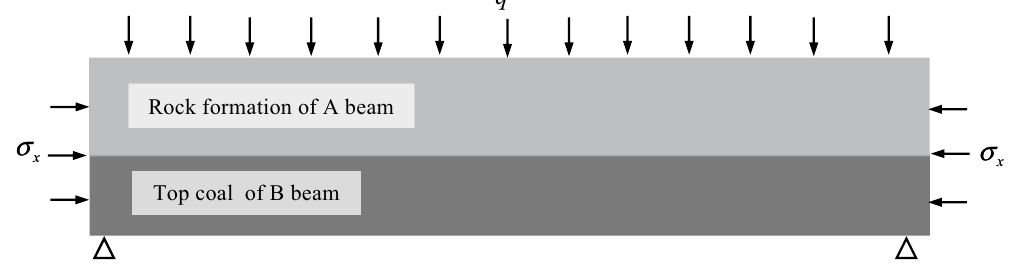
Figure 2. Mechanical model of the roof of the top coal roadway in thick